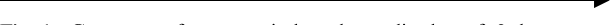
Fig. 1. Contours of mean wind and amplitudes of 2-day wave, diurnal and semidiurnal tide at Yamagawa (31 (cid:176) N) during the time from September 1996 to September 1997 (derived with a sliding data window of 10 days). The contour spacing is 10 m/s for the zonal mean wind and else 5 m/s. Dashed contours denote negative values (westward or southward mean wind). At the bottom of each graph the cross section of the contours at height 86 km is depicted. The scale for the cross section is on the right axis of the graph